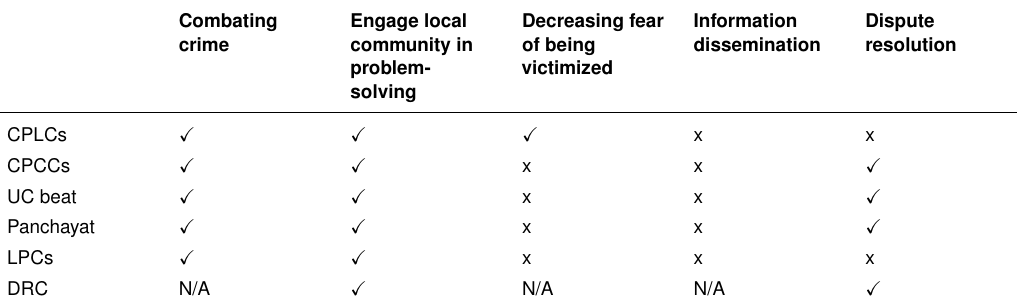
Table 3. Objectives of COP